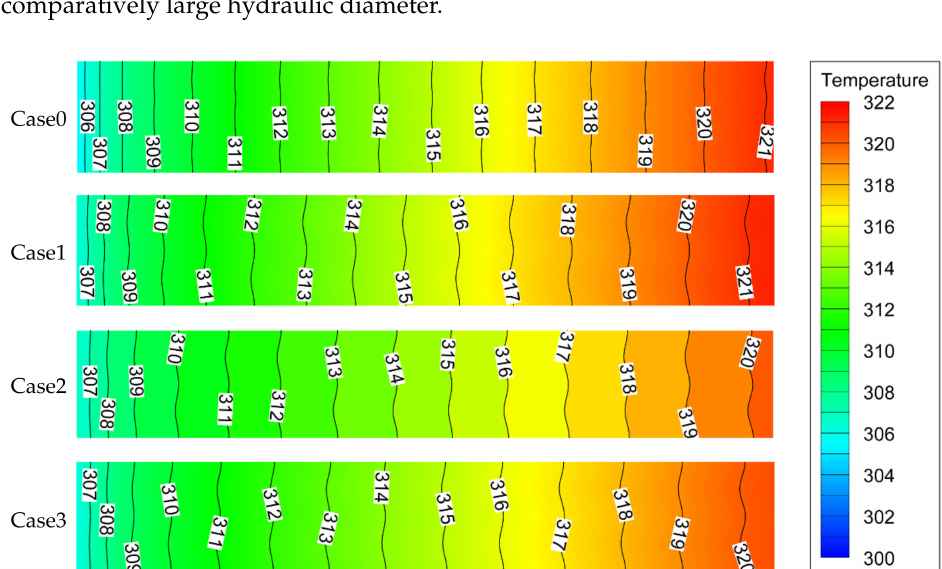
comparatively large hydraulic diameter.